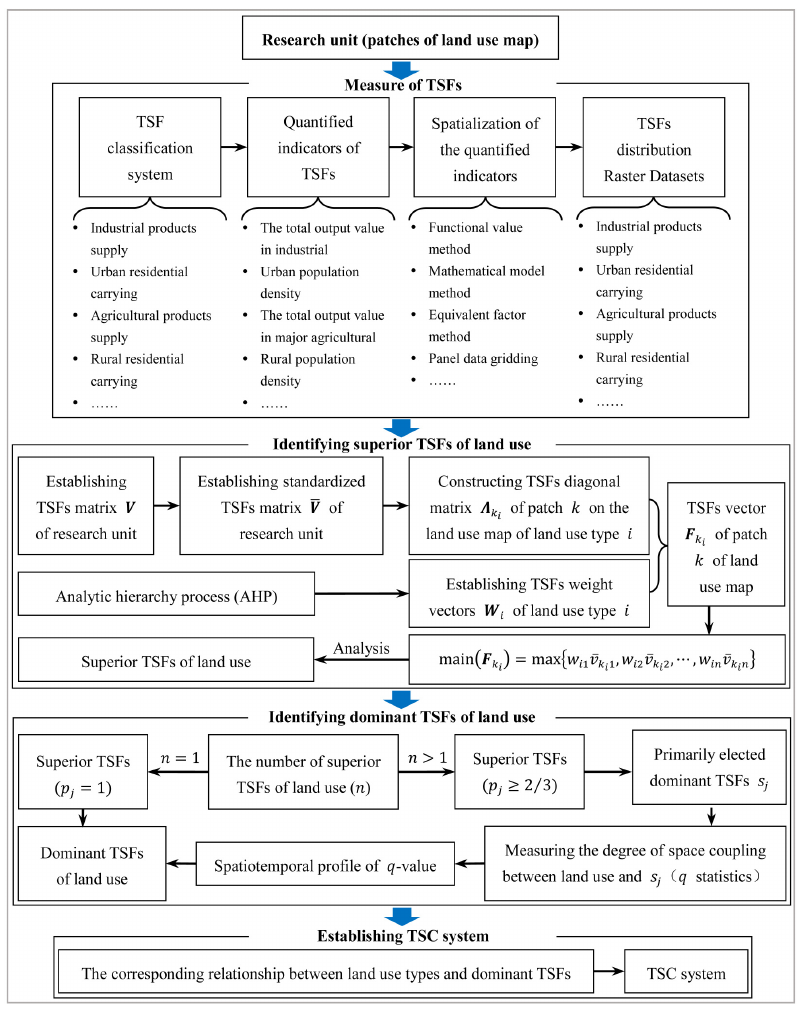
, 𝑾 , 𝑭 , W i , F k is (cid:3036) (cid:3038) (cid:3284) is (cid:3284) i i